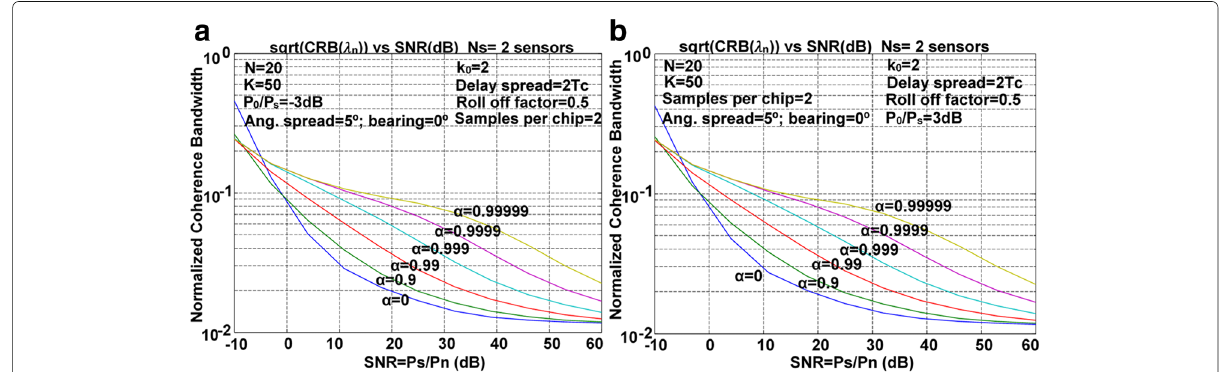
Fig. 9 CRB of the normalized coherence bandwidth λ n in terms of the dispersed SNR. Results are provided for different values of the temporal correlation coefficient λ , and for different values of the LOS component power. Two sensors and 50 channel vector estimates are available. The sampling rate set to twice the chip rate and a roll-off factor of 0.5. Delay spread set to 2 T c and angular spread set to 5°. Bearing direction is the broadside. a Left: LOS power set 3dB lower than the dispersed signal power. b Right: LOS power set 3 dB higher than the dispersed signal